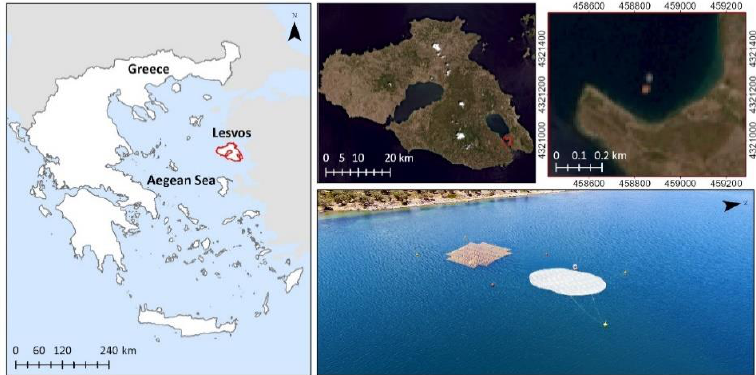
Figure 1. Location map showing the study area in the Island of Lesvos. Top right: Sentinel-2 subscene of the deployment area showing the HDPE (top) and wooden targets. Bottom: UAS image of the deployment area showing HDPE and wooden targets.